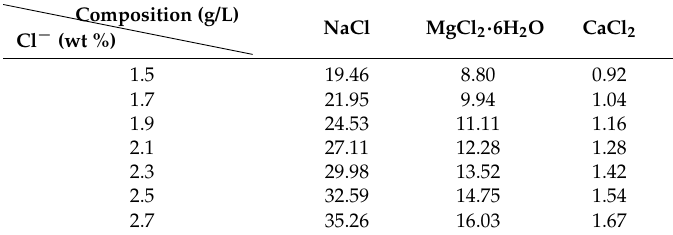
Table 2. Chloride formulation compositions of artificial seawater with different chloride ion concentrations.